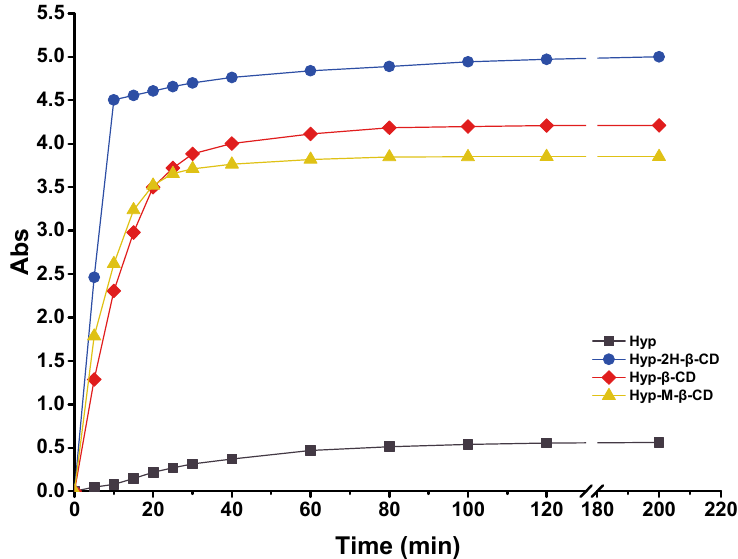
Figure 8. Solubility properties of Hyp, Hyp–2H- β -CD, Hyp– β -CD, and Hyp–M- β -CD in water. The apparent stability constant ( K s ) of the host and guest were determined via UV–vis absorption spectrum titration. As shown in Figure 9a, when Hyp was in excess (10 mg), the absorption value of Hyp increased with the increasing concentration of 2H- β -CD. With the addition of 2H- β -CD, the absorption band of Hyp blue moved slightly at 355 nm, and the shoulder peak appeared at 360 nm. As the concentration of 2H- β -CD increased, the absorbance value of Hyp increased, and the color of the formed ICs deepened gradually with the increase in the Hyp concentration, as was visible to the naked eye (Figure